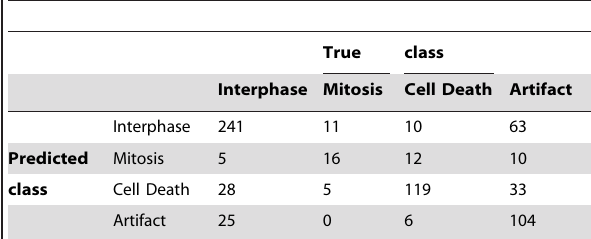
Table 1. Confusion matrix of the classification results after automated